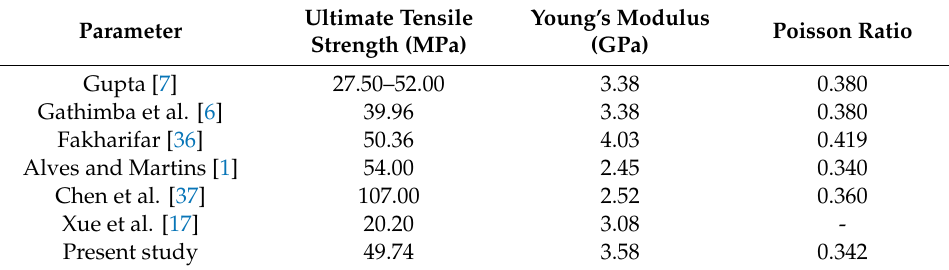
Table 5. Physical property of uPVC pipe by other researchers.